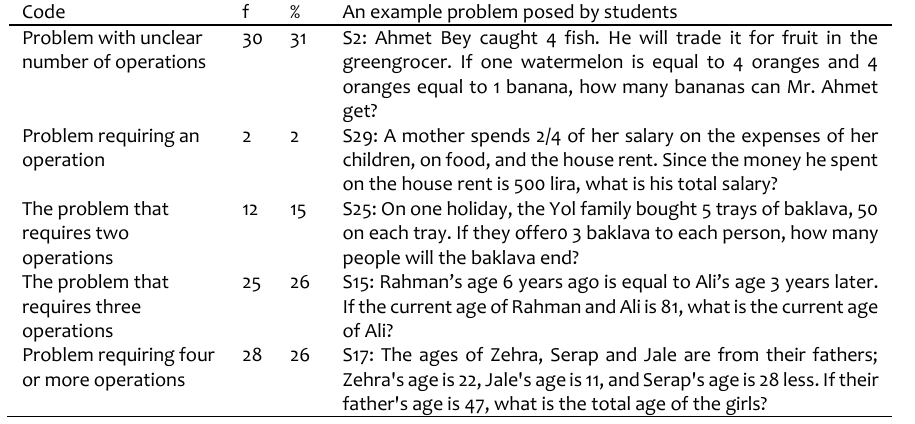
Table 5. Examination of the problems in terms of